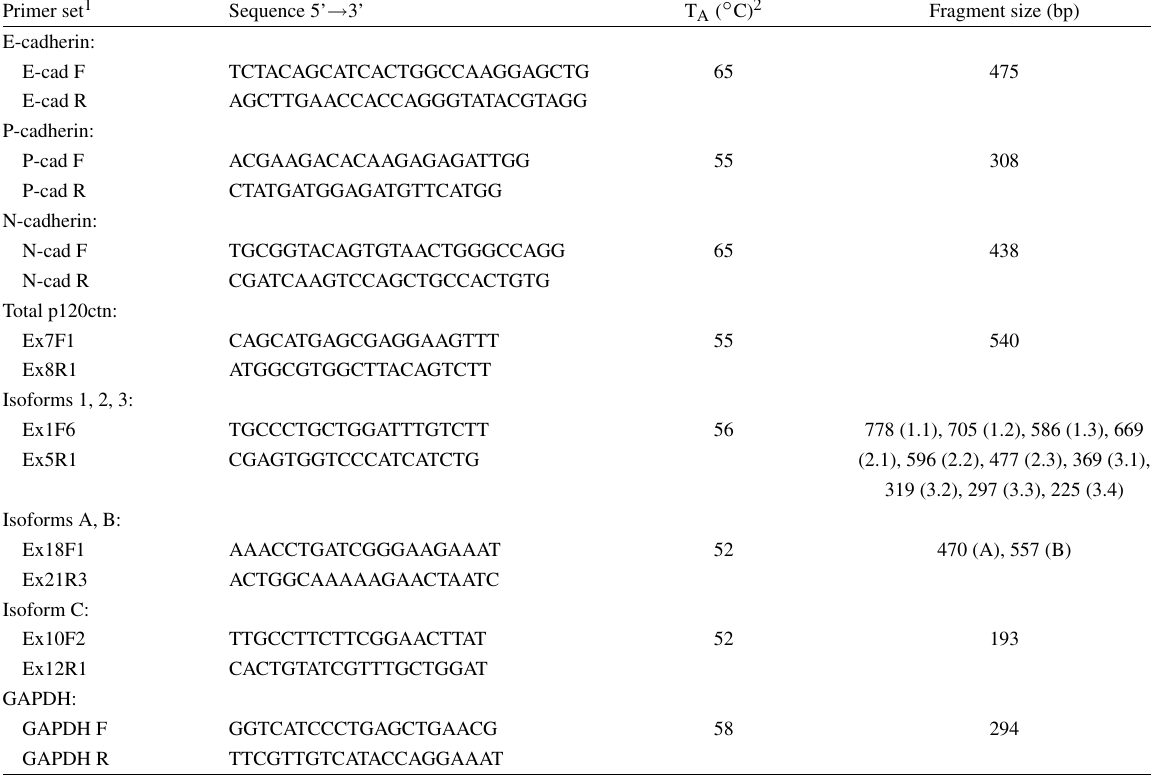
Sequences of the primers used to amplify E-, P- and N-cadherin transcripts, total p120ctn mRNA and its several spliced alternative isoforms. Primers to amplify GAPDH mRNA, as an internal control, were also used Primer set